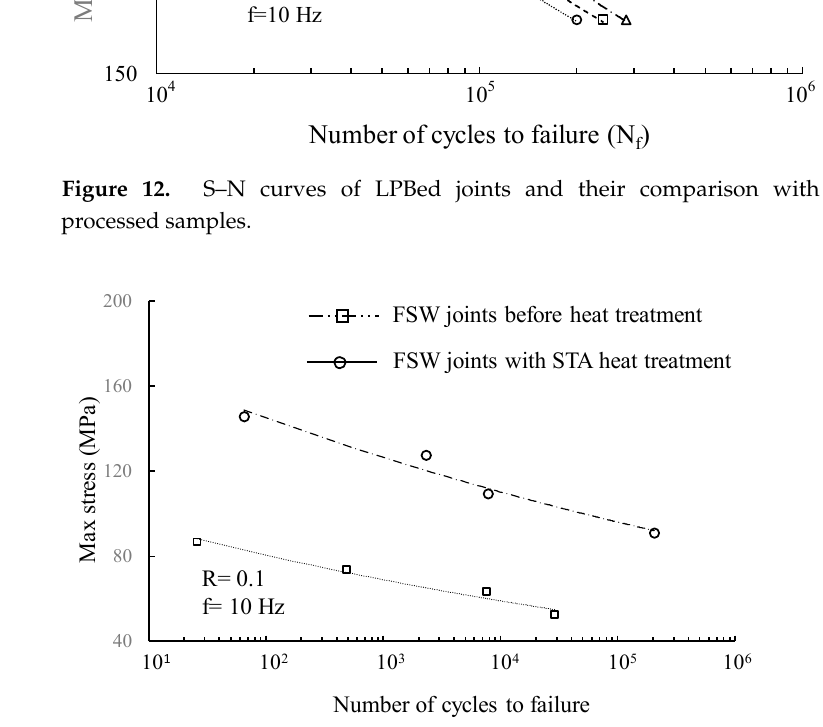
Figure 13. Stress–fatigue life data of heat-treated FSW samples and their comparison with those of as-welded joints.